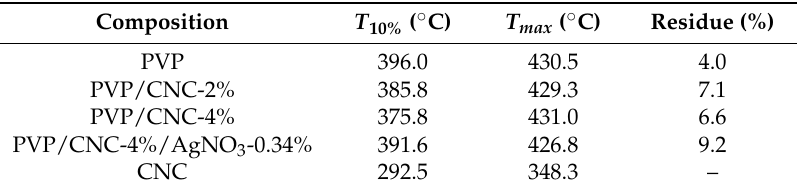
Table 3. Summary of TGA and DTG curves of electrospun PVP, PVP/CNC-2%, PVP/CNC-4%, and